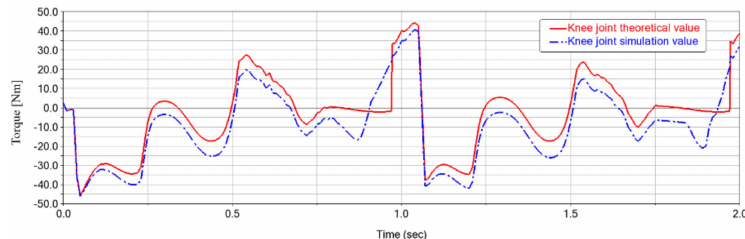
Figure 25. Hip joint torque change rule diagram.